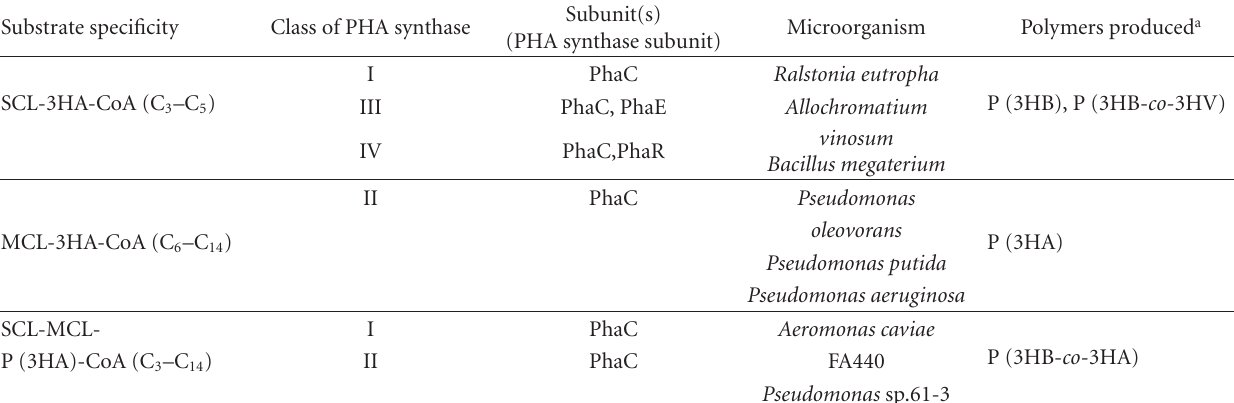
Table 1: Classes of PHA synthases and varieties of P (3HA)s (adapted from Rehm 2007) [10]. Substrate